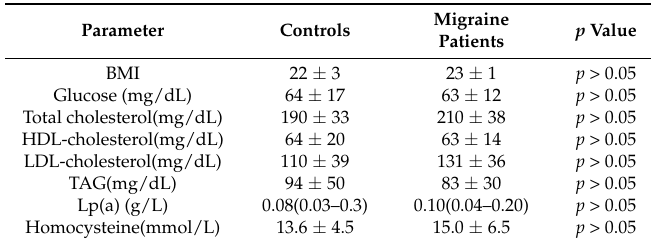
Table 2. Body mass index (BMI), glucose, plasma lipids and homocysteine concentrations in migraine patients and controls.